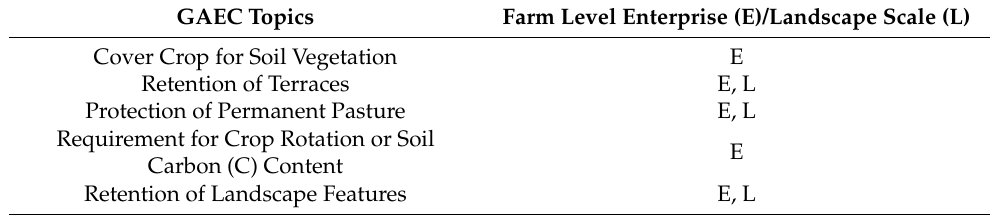
Table 2. Overview of GAEC Topics. GAEC Topics Farm Level Enterprise (E)/Landscape Scale